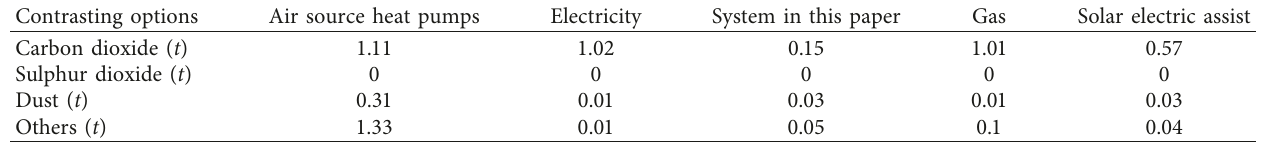
Table 3: Pollutant emissions in different systems.